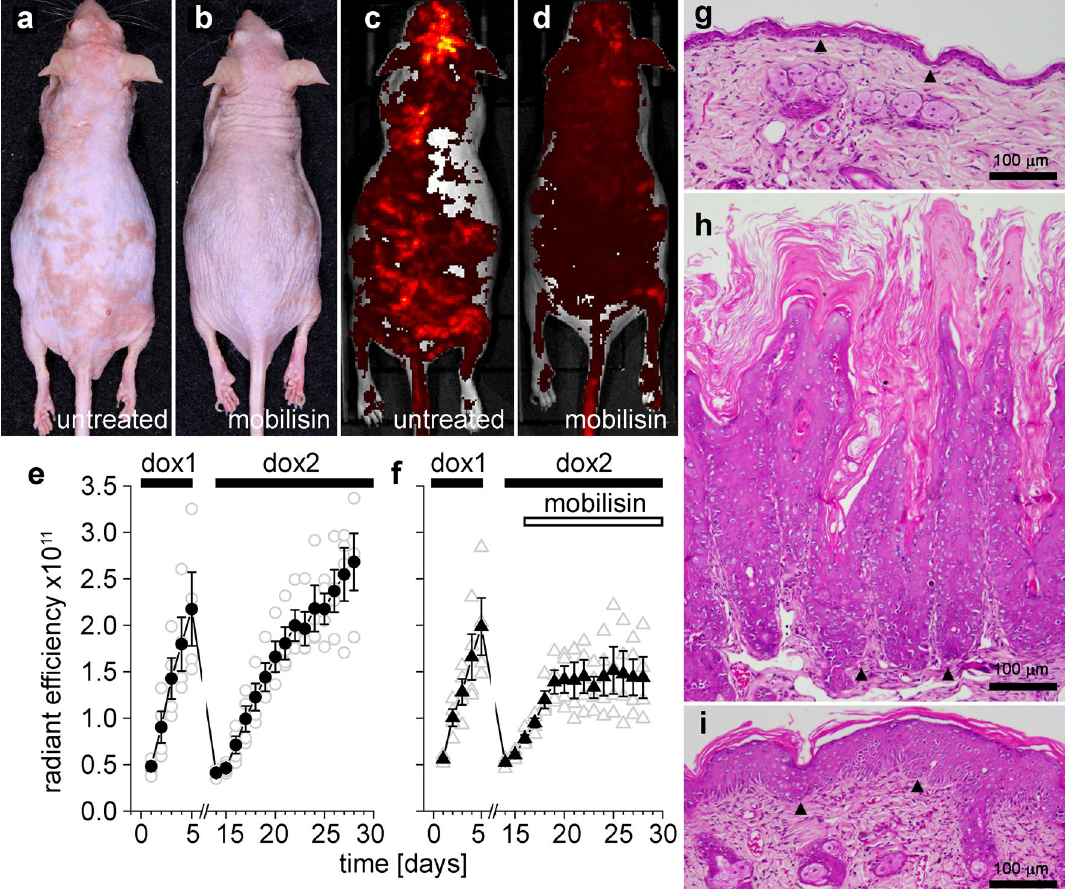
Figure 4. Mobilisin treatment reduced epidermal pathology. Untreated mice ( a ) displayed more severe skin pathology than Mobilisin treated animals ( b ) that correlated well with IVIS images of EGFP fluorescent intensity ( c , d ). Radiant efficiency plots for untreated ( e ), or Mobilisin treated ( f ), mice after an initial doxycycline induction (dox1) without FFA treatment, removal of doxycycline, then a second doxycycline induction (dox2) with FFA treatment of one group of animals. Wild-type mice ( g ) showed normal epidermal structure and thickness. Untreated Cx26-G45E transgenic mice ( h ) displayed typical KID pathology. Mobilisin treatment ( i ) significantly reduced, but did not eliminate, hyperkeratosis. Filled symbols are means ± SE, open symbols are raw data. n = 4/group. Black arrowheads mark the epidermal/dermal